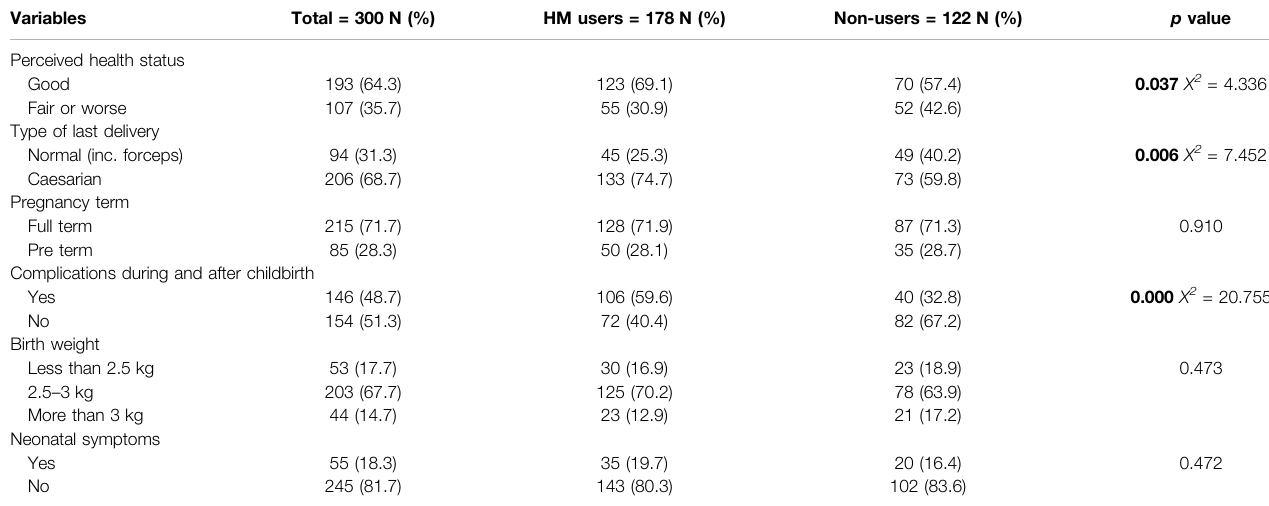
TABLE 4 | Pregnancy outcomes of